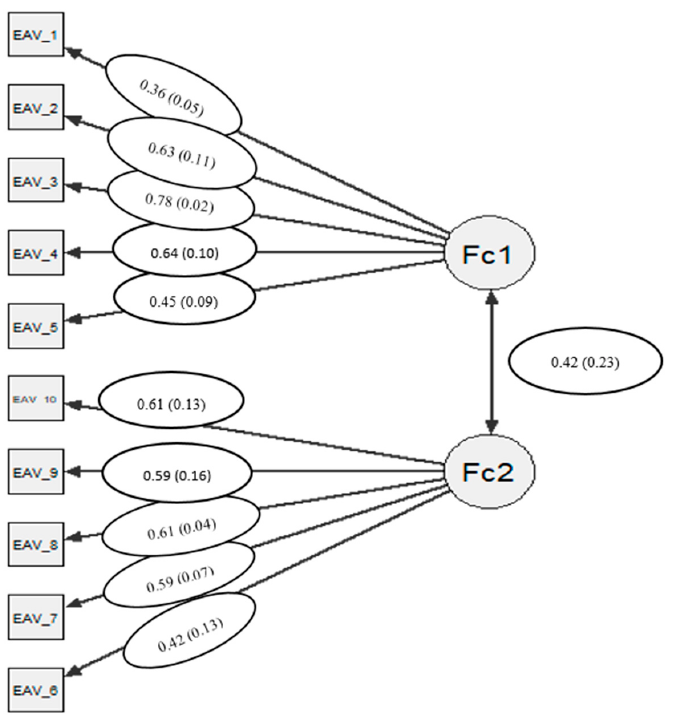
Figure 1. Path diagram of the two factor dimensional model of the Attitudes Scale towards Violence (EAV). Note . In circles factor loadings (measurement errors).